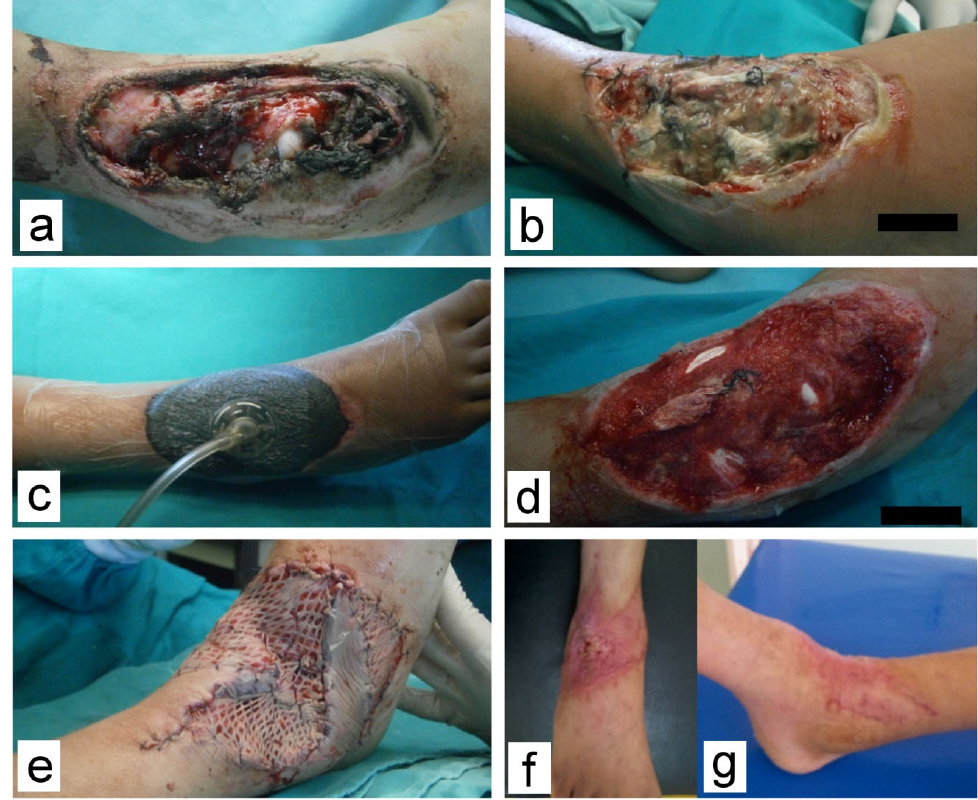
Figure 1. Complex wound with soft tissue defect in the region of the right talocrural joint. ( a ) At presentation; ( b ) Before debridement and V.A.C. ® , 4 days post injury; ( c ) After V.A.C. ® was applied; ( d ) Development of healthy granulations after 7 days of VAC treatment; ( e ) Wound was covered by STSG and local flaps after 13 days; ( f , g ) At the one ‐ month follow ‐ up.